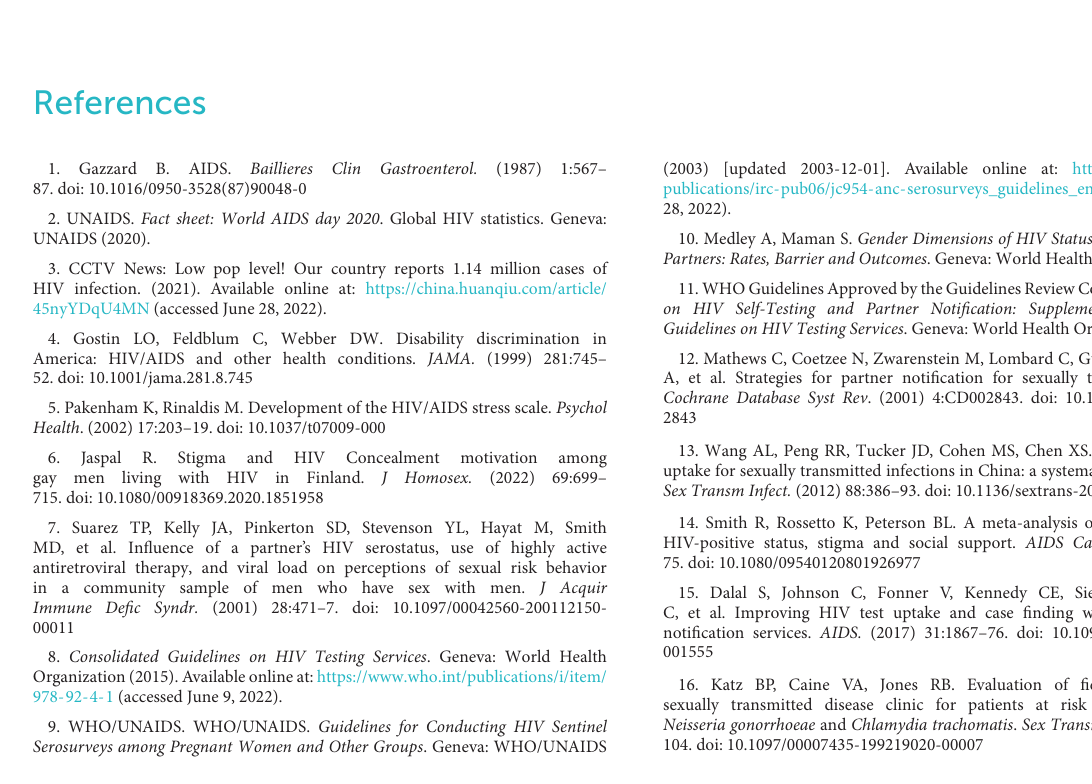
SUPPLEMENTARYTABLES3 Subgroup analyses of HIV disclosure to sexual partners. SUPPLEMENTARYFIGURES1 Funnel plot of HIV disclosure to sexual partners among PDWH. SUPPLEMENTARYFIGURES2 Sensitivity analysis for the pooled proportion of HIV disclosure to sexual